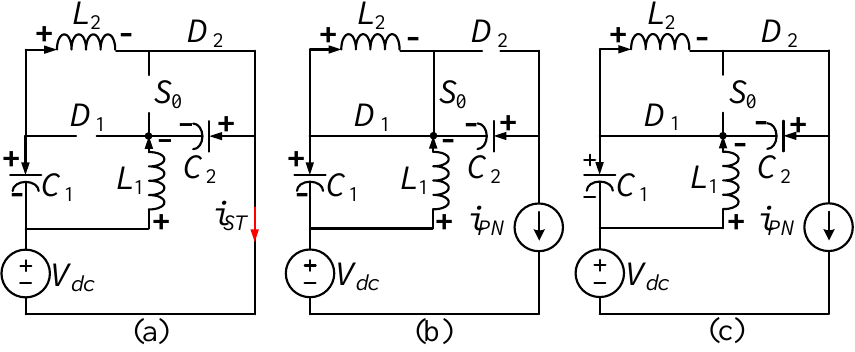
Figure 2. Operating modes of ADC-qZSI. ( a ) ST mode, ( b ) non-ST mode 1, ( c ) non-ST mode 2.